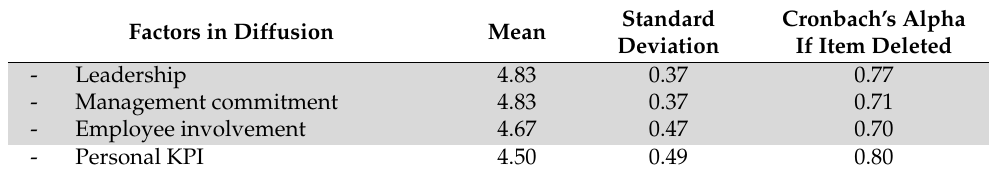
Table 8. Calculation of Q3 mean and Q1 standard deviation of diffusion indicator